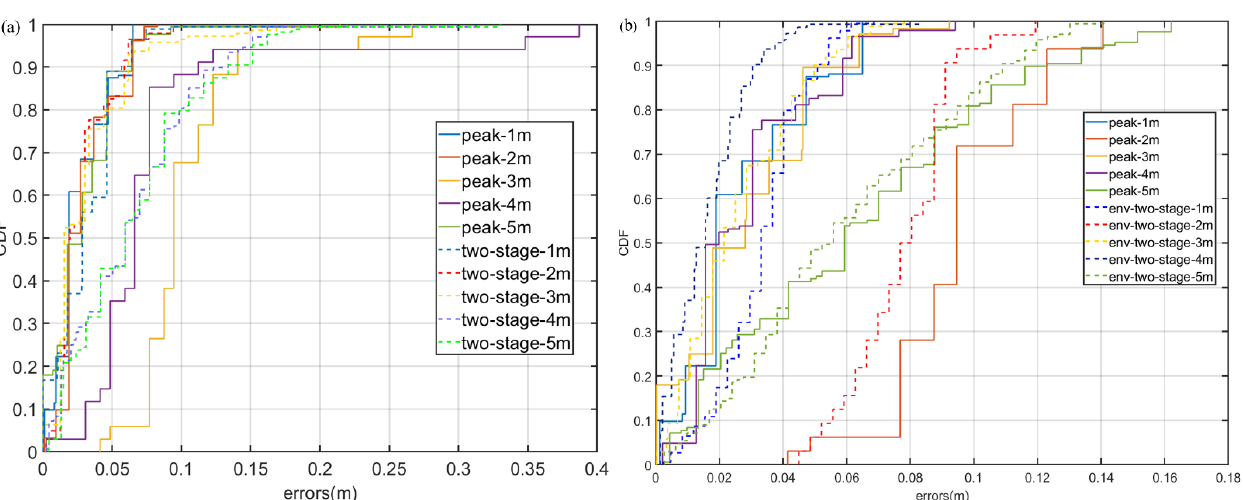
Figure 23. Error distribution in Case 1. ( a ) ranging in method Peak. ( b ) ranging in method two-stage. ( c ) ranging in method env-two-stage.